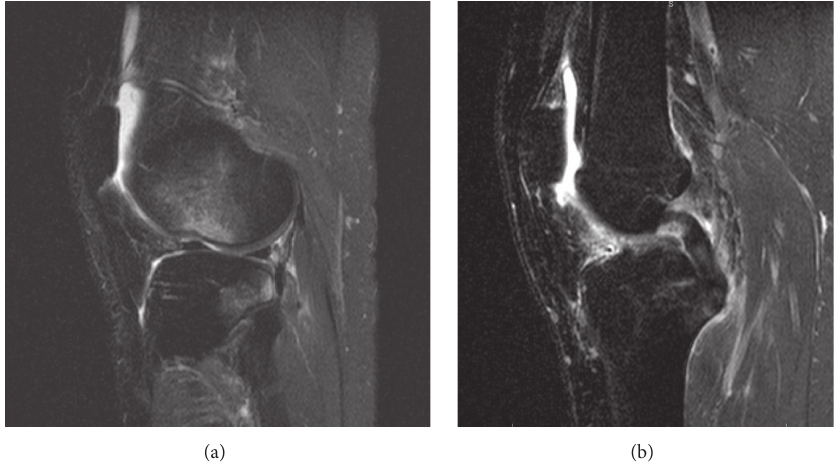
Figure 2: T2 weighted fat suppressed sagittal plane MRI images for evaluation of acute knee injury. Classic marrow contusion pattern at the lateral terminal sulcus and posterior aspect of the lateral tibial plateau (a) and complete rupture of anterior cruciate ligament (b).